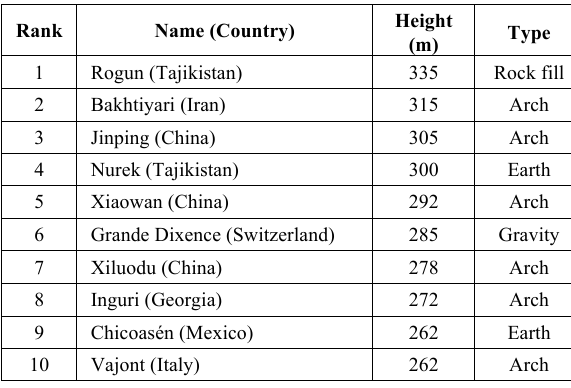
TABLE III. T EN H IGHEST D AMS